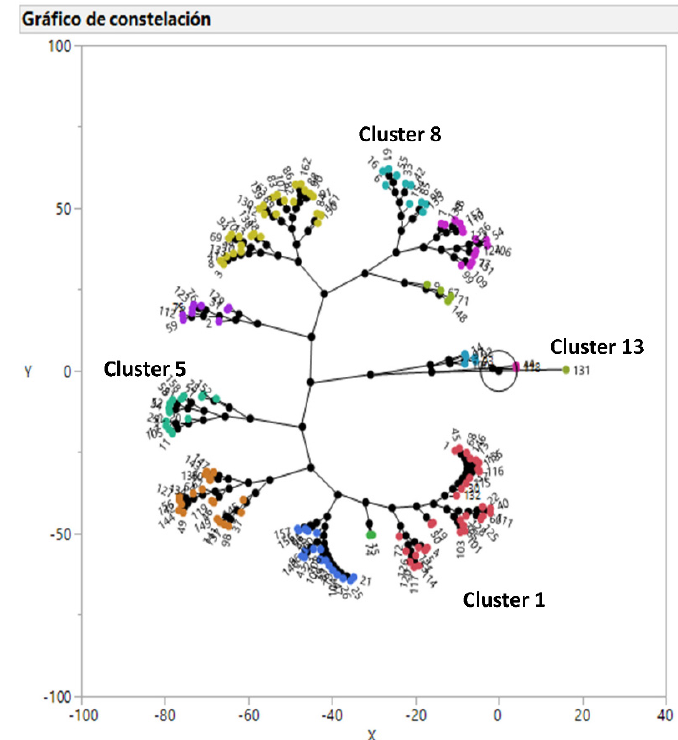
Figure 1. Constellation plot showing the results of 162 Actinobacillus pleuropneumoniae isolates after a hierarchical clustering analysis of MIC values for the 10 antimicrobials tested. The numeration begins in cluster 1 and ends in cluster 13 clockwise. Table 1. Antimicrobial susceptibility pattern for the 13 clusters obtained from 162 Actinobacillus pleuropneumoniae isolates after a hierarchical clustering analysis. It is detailed in brackets the number of strains belonging to each cluster. Suitable antimicrobials are detailed in green color. The antimicrobials tested included amoxicillin (AMO), ceftiofur (CEF), doxycycline (DOX), enrofloxacin (ENR), florfenicol (FLO), sulfamethoxazole/trimethoprim (SFM), tiamulin (TIA), tilmicosin (TILM), tildipirosin (TILD), and tulathromycin (TUL).